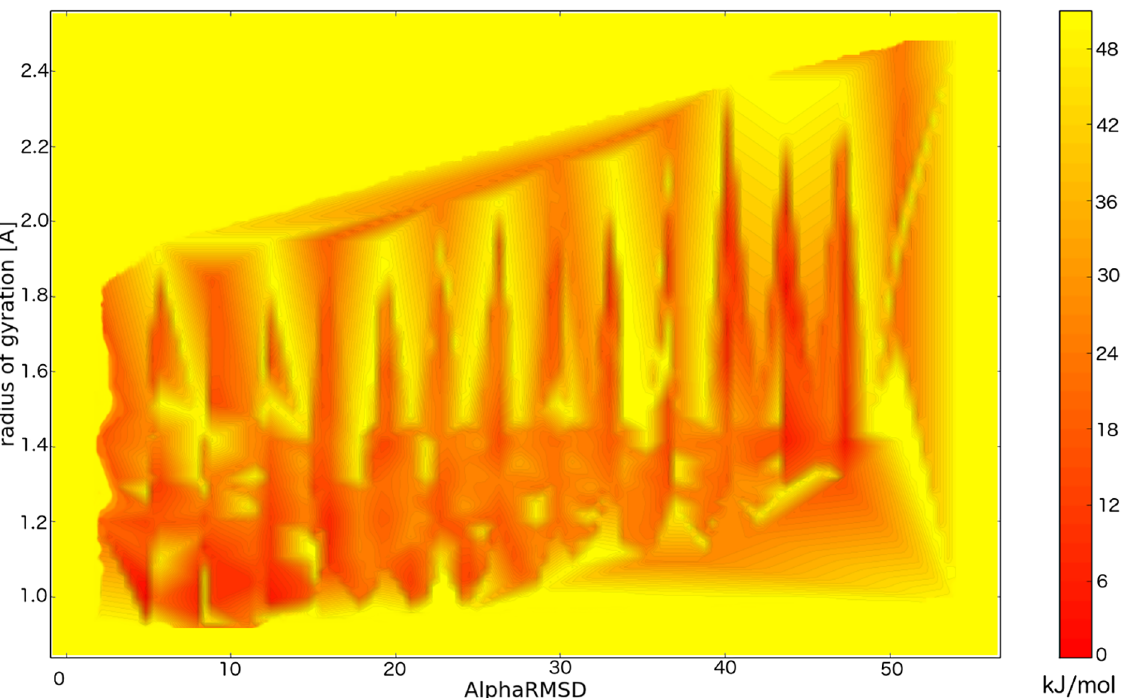
Fig 2. Free energy surface of Val60 in the CamTube force field. The x and y axes represent two CV variables: the number of α -helical six-residue-long fragments and the radius of gyration.